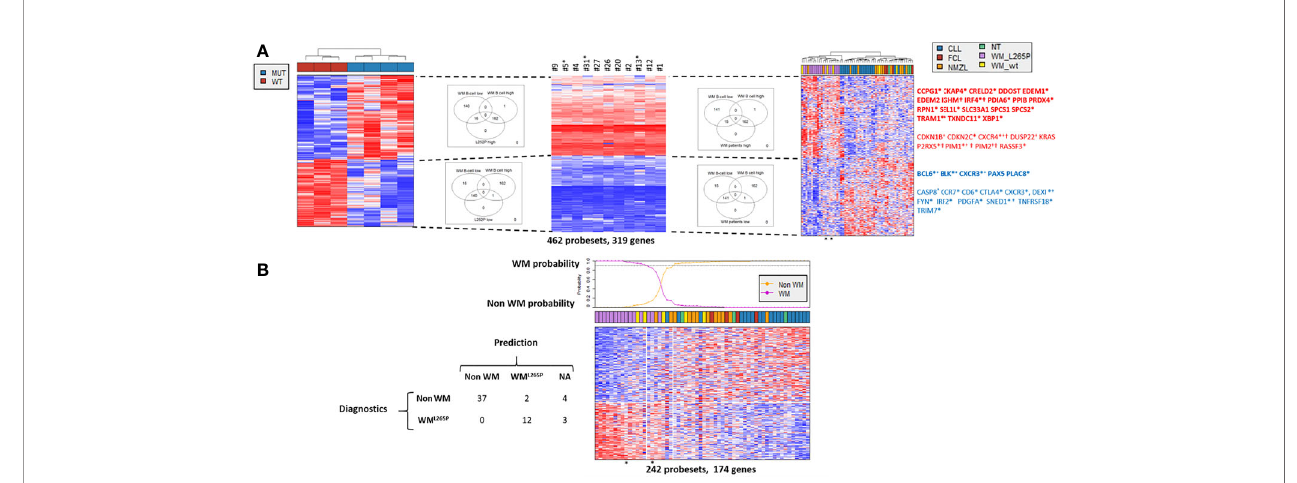
FIGURE 10 | Comparison of gene expression pro fi le (GEP) of Myd88 L252P mice and patients with WM or other indolent B-cell NHL. Affymetrix differential gene expression pro fi les (GEP) between four Myd88 L252P mice (MUT, n=4) and three Cd19 Cre mice (WT, n=3) were compared to the Affymetrix GEP of puri fi ed bone marrow tumor B-cells from 11 WM patients with the MYD88 L265P mutation, resulting in selection of 462 probesets (319 genes). This selection was used on the Affymetrix transcriptome of an independent series of lymph node biopsies from 58 patients: 19 MYD88 wt chronic lymphocytic leukemias (CLL), 15 MYD88 L265P WM (WM_L265P), 12 MYD88 wt nodal marginal zone lymphomas (NMZL), 5 MYD88 wt WM with IgM peaks (WM_WT), 4 follicular lymphomas (FCL) and 3 patients with follicular hyperplasia (NT). (A) Hierarchical clustering and heatmap of the 462 selected probesets for mice (left), puri fi ed bone marrow MYD88 L265P WM B-cells (middle) and lymph nodes (right). Down and up-regulated genes are in blue and red respectively. Branches of down and up regulated genes in Myd88 L252P mice, MYD88 L265P WM bone marrow B-cells and MYD88 L265P WM lymph nodes are delineated by dashed lines. Venn diagrams of the intersections between the branches are shown, highlighting the consistency between branches across the different clustering. Some genes of interest are noted on the right. In bold are those of the plasma cell signature; *: genes in the predictor (see Figure 7B ); +: genes reported by Hunter et al. in WM (30); † : genes of the ABC/GC DLBCL signature (31). (B) : Informativeness of MYD88 L265P WM diagnosis using the 462 selected probesets de fi ned in Figure 8A . The 462 probesets de fi ned from MYD88 L252P mice and bone marrow tumor B-cells from MYD88 L265P WM patients were used to predict MYD88 L265P WM diagnosis (WM L265P versus non WM) from other lymphomas within the series of 58 lymph node biopsies. Probabilities that each sample belongs to WM L265P versus non WM group are indicated. The WM L265P versus non WM or not attributed (NA) assignment is shown on the